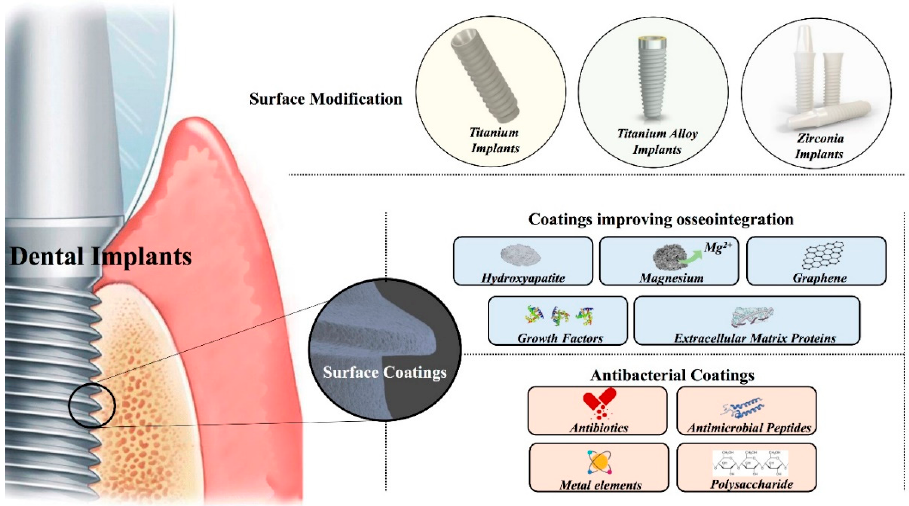
Figure 1. A schematic illustration of Surface Modifies and Functional Coating of Dental Implants.